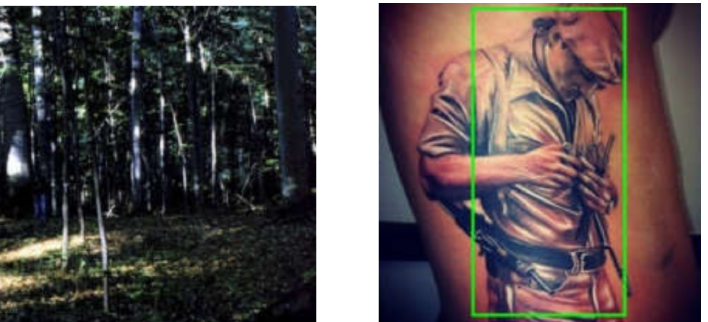
Figure 18. Failure case of the method proposed by Sarin et al. [58]. Human and face detector fails in low light and gets fooled by non-living human-like objects in images. Reprinted with the permission from [58]. Copyright 2015 IEEE.